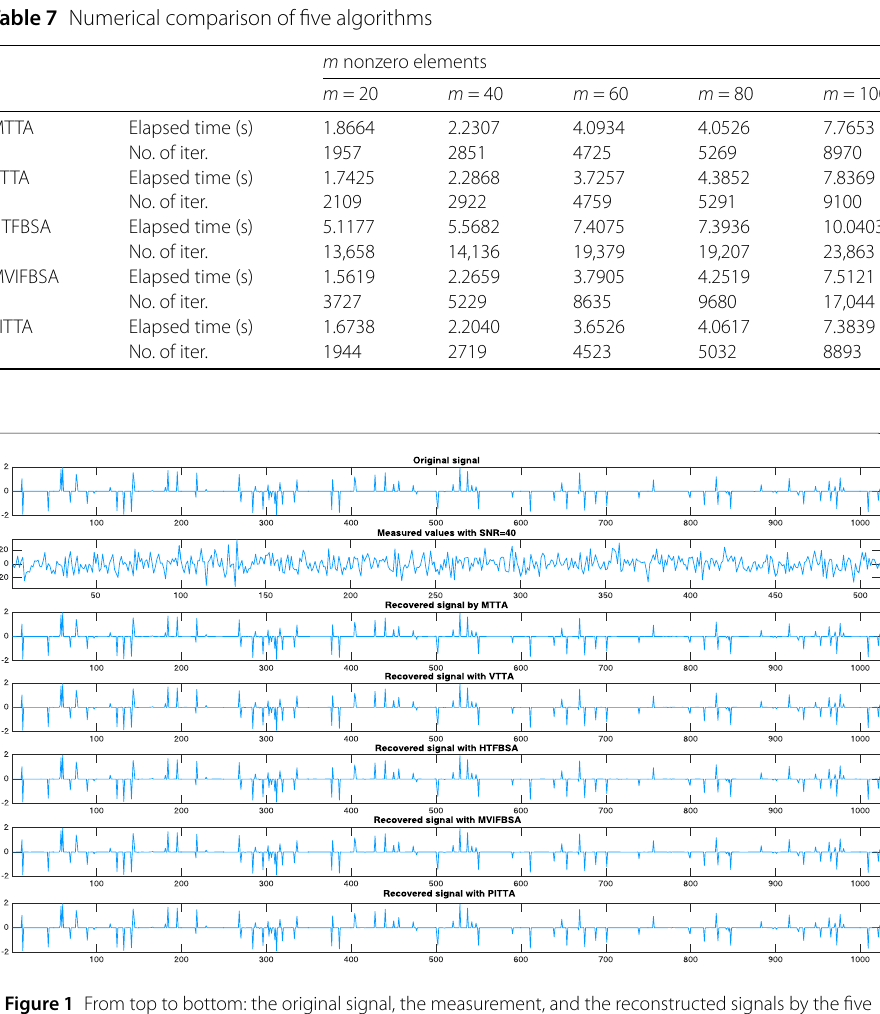
Figure 1 From top to bottom: the original signal, the measurement, and the reconstructed signals by the five algorithms in Table 7 for m =